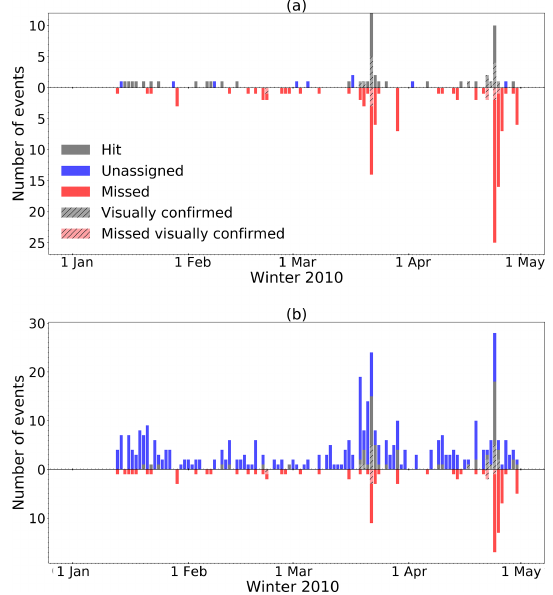
Figure 9. Classification results using a minimal event duration length of 12s for (a) sensor 1 and (b) sensor 7. Grey bars show the number of matching detections (hit), blue bars show the unassigned events and the red bars show the events that were not detected as an avalanche (missed). The hatched bars indicate the number of hits (grey) or misses (red) for the confirmed